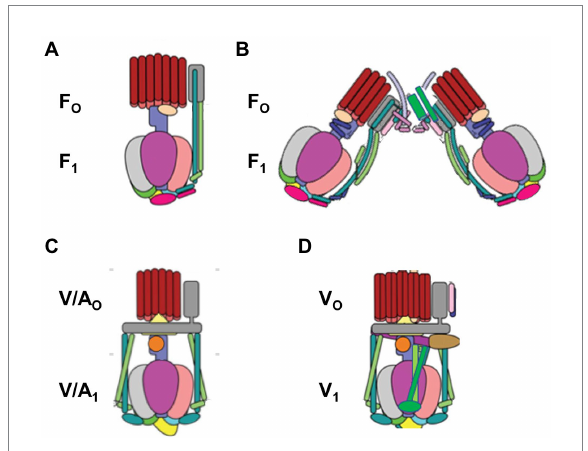
FIGURE 1 Structural variations among the family of rotary ATP synthases and ATPases that are coupled to transmembrane proton, or rarely sodium, gradients. (A) F-type ATP synthases in bacteria and plant chloroplasts (pdb-IDs 6OQR and 6FKF). (B) F-type ATP synthases in mitochondria (pdb-ID 6B8H). (C) V-type ATPases in some bacteria such as E. hirae and V/A-type ATP synthases in archaebacteria (pdb-ID 6R0Z) (D) V-type ATPases in vacuoles (pdb-ID 3J9V). V-type motors are incapable of synthesizing ATP and are used to pump protons to create a transmembrane pH gradient.